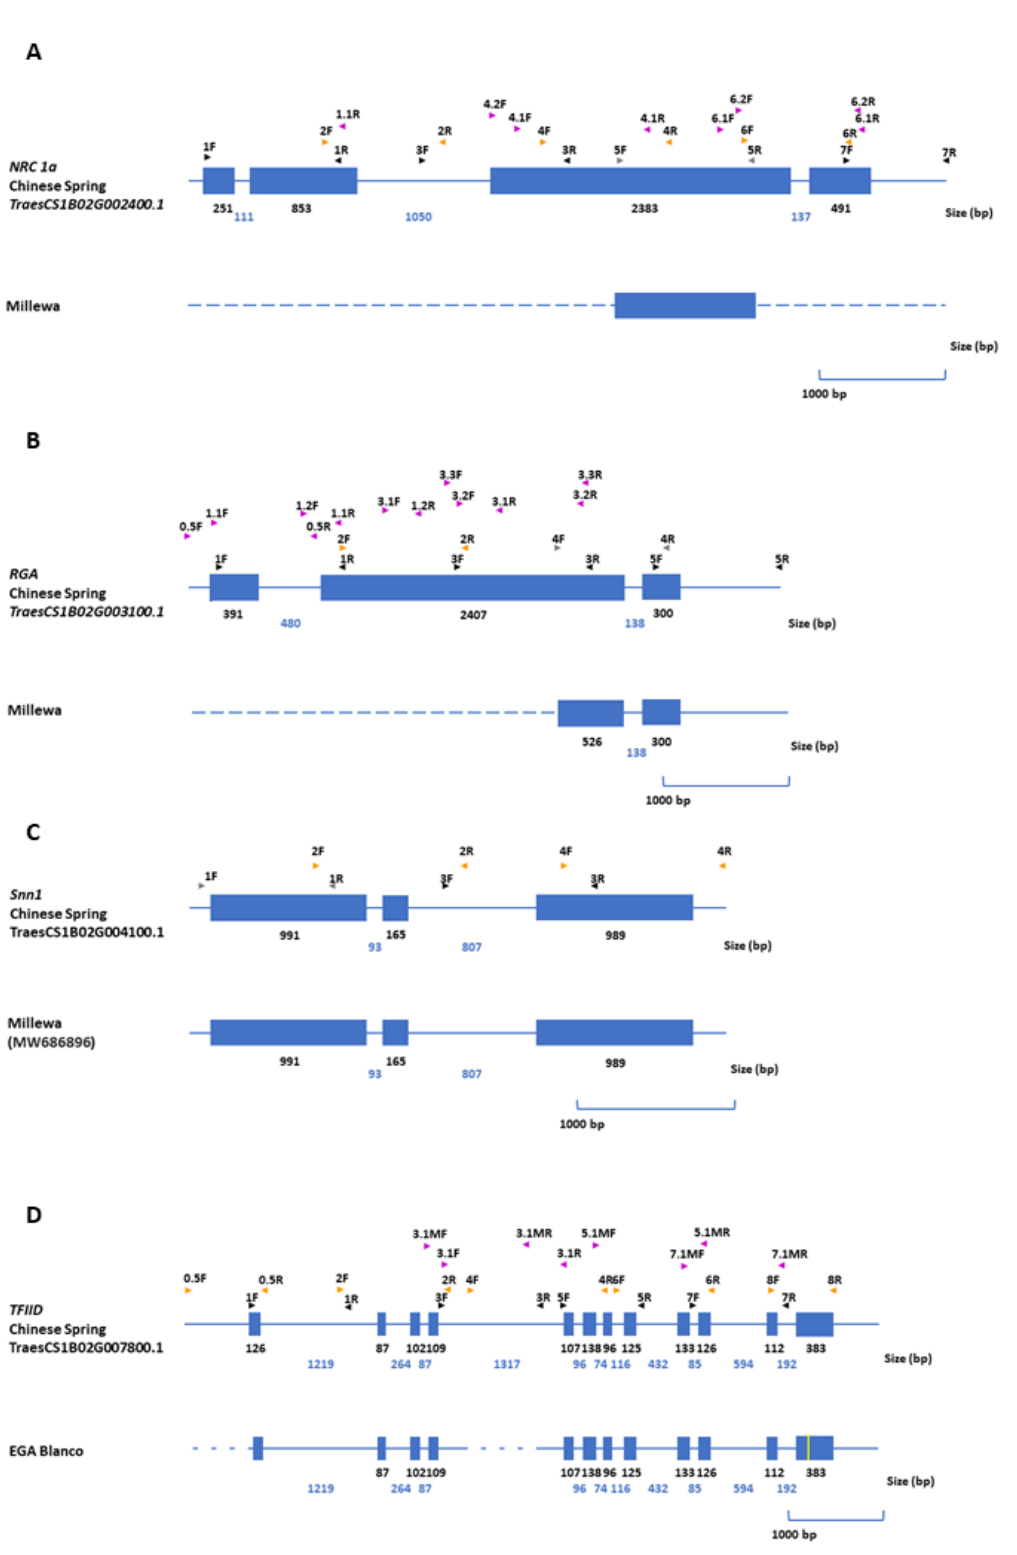
Figure 3. Gene structure for ( A ) NRC1a , ( B ) RGA , ( C ) Snn1 and ( D ) TFIID on chromosome 1BS from reference sequence and varieties. Blue lines and boxes represent introns and exons, respectively, for annotated genes from the reference sequence. Position of PCR primers for amplifying tiling paths from varieties are shown above gene structure from the Chinese Spring reference sequence. Size of introns and exons are shown in base pairs (bp). Dashed blue lines represent regions where tiling paths were unable to be amplified in corresponding varieties. Yellow lines represent SNP between Chinese Spring and varieties. Genbank accession numbers for complete annotated genes are provided in